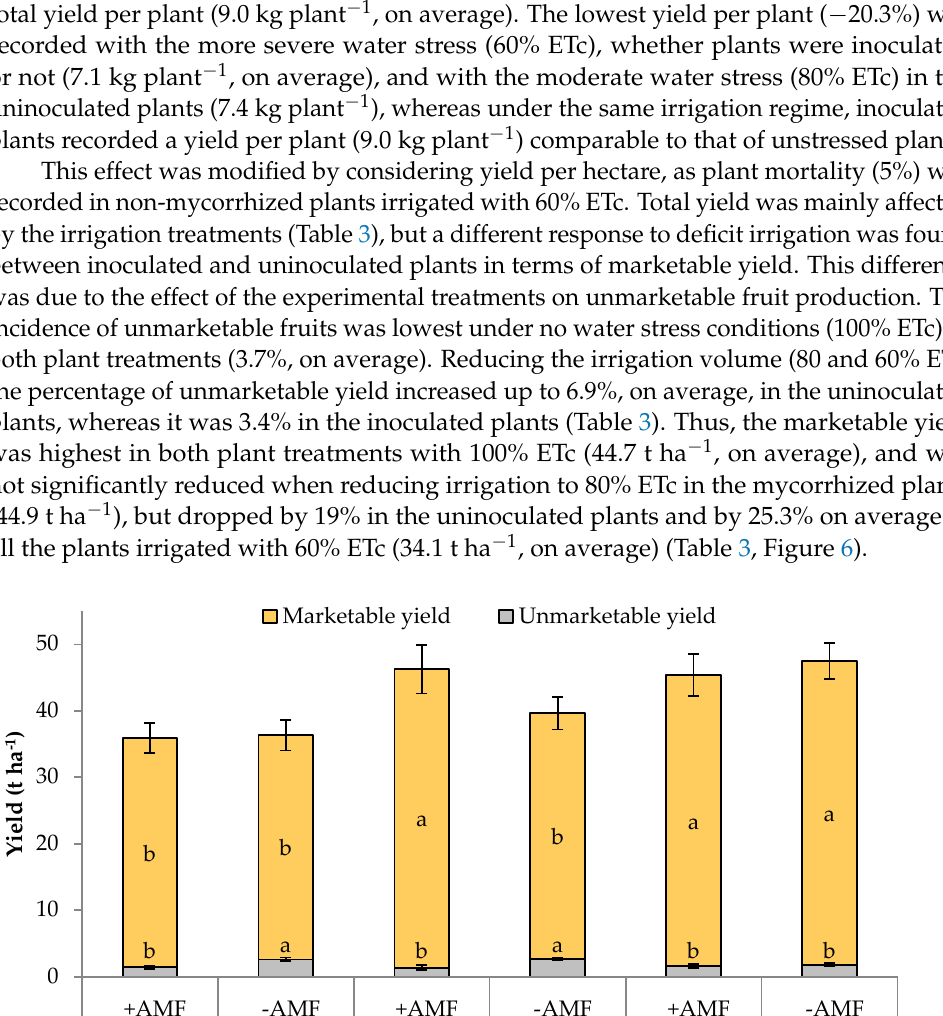
Table 4. Effect of irrigation treatments and plant inoculation with arbuscular mycorrhizal fungi (AMF) on melon fruit characteristics during two years of experiments (SSC: soluble solid content; TA: titratable acidity).